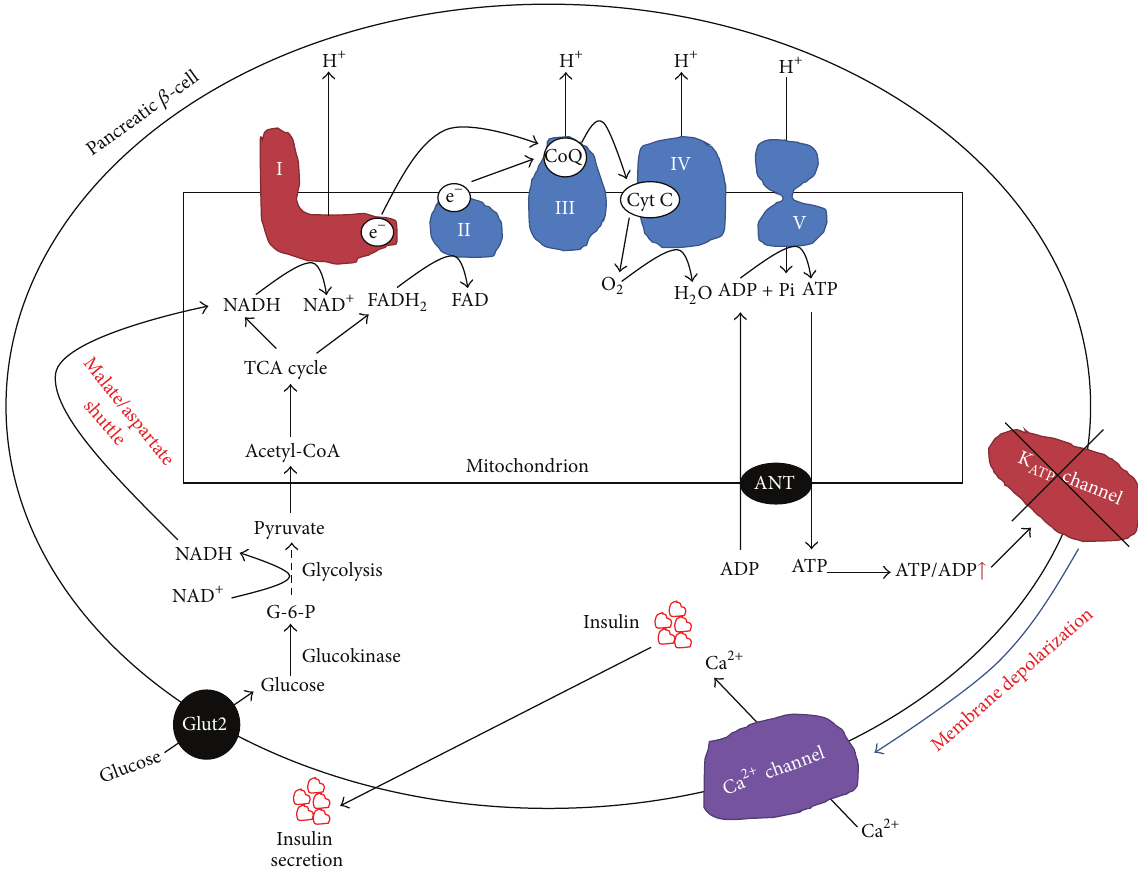
Figure 3: Mechanisms of 𝛽 cell glucose sensing and insulin secretion. Shown is the first phase of insulin secretion stimulated by glucose derived ATP. When glucose levels are high, ATP levels are high, which depolarizes cell membranes, triggers the closure of the K ATP channels, and induces opening of the Ca 2+ channel. Consequently, insulin granules are infused with membranes and insulin is released. Complex I plays a key role in this process as ATP production is driven by its oxidation of NADH and transportation of electrons to CoQ that accompany proton pumping needed for ATP synthesis by complex